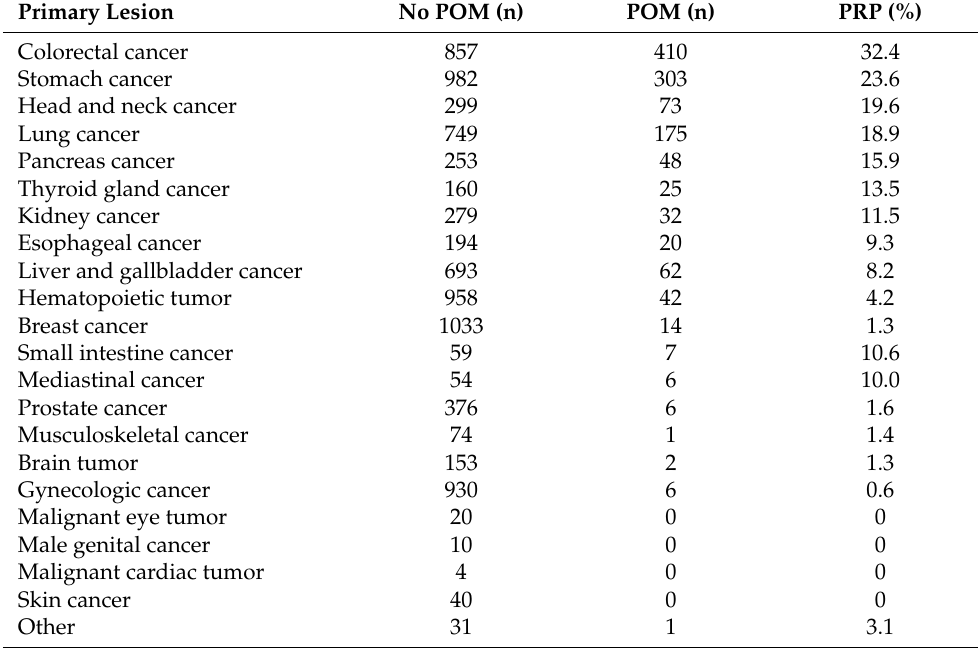
Table 3. Comparison of PRP by the primary